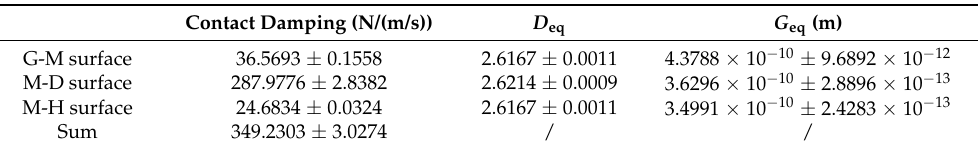
Table 3. Parameters (estimated value ± standard uncertainty) of contact surfaces with a pre-stress of 10